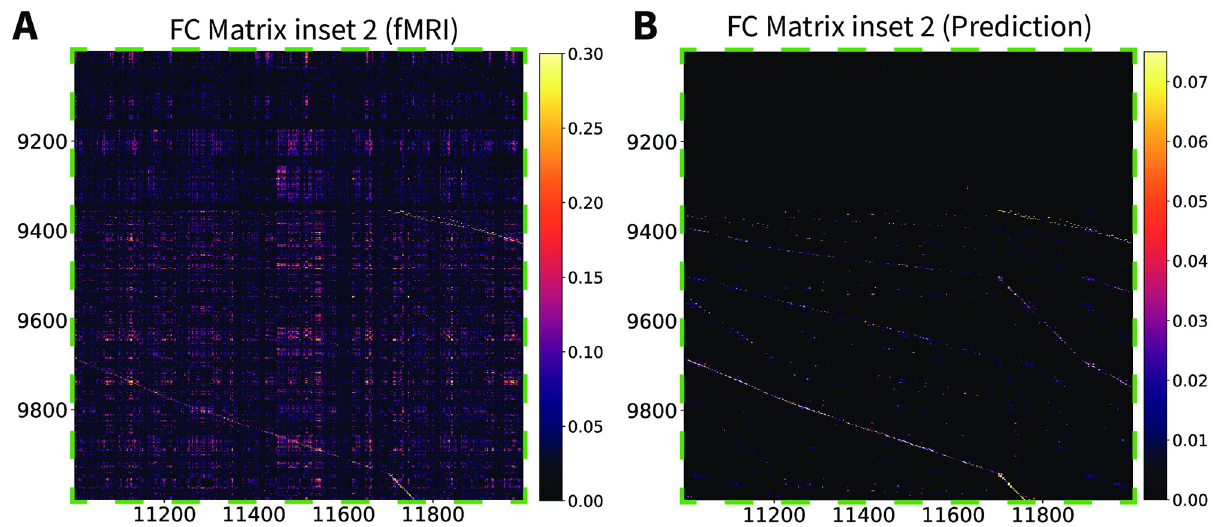
Fig 9. Stochastic Wilson-Cowan graph neural field model predicts the experimental functional connectivity matrix (inset 2). (A) An inset of the vertex-wise, resting-state fMRI functional connectivity matrix for a single subject. (B) The same inset for the Wilson-Cowan graph neural field model with the parameters of S2